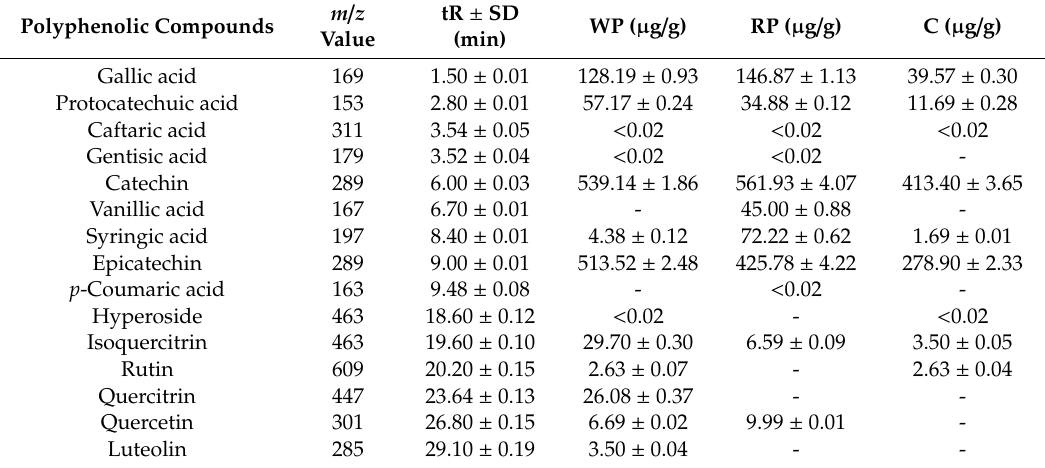
Table 4. The polyphenolic content in the studied extracts ( µ g / g dry vegetal material). Polyphenolic Compounds